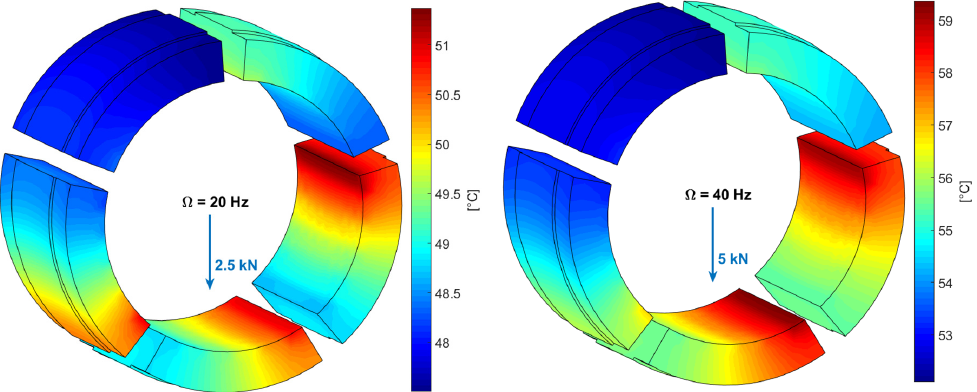
Figure 20. Average predicted temperature distribution of pad #2 is higher than ( left ) or nearly equal to ( right ) that of pad #1.